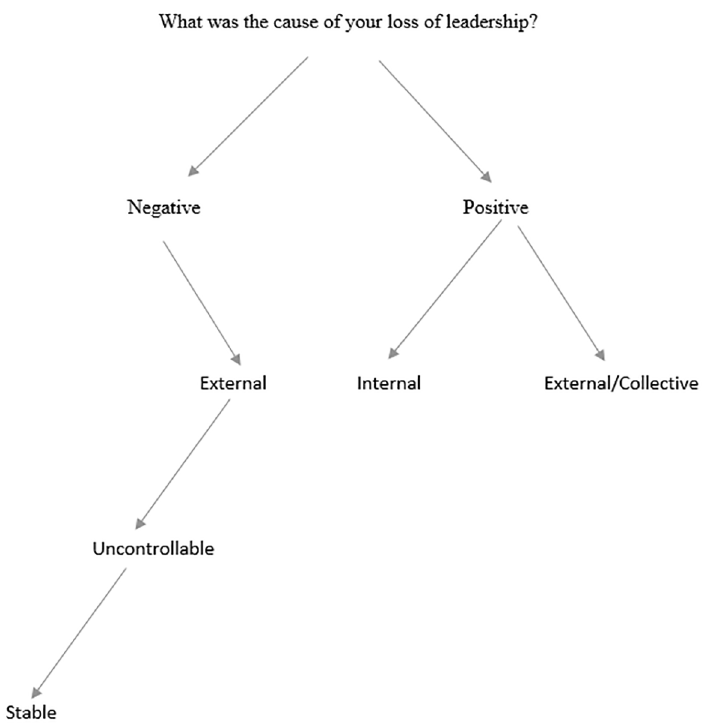
Figure 2. Three-dimensional intra-political attributional causality towards returning to